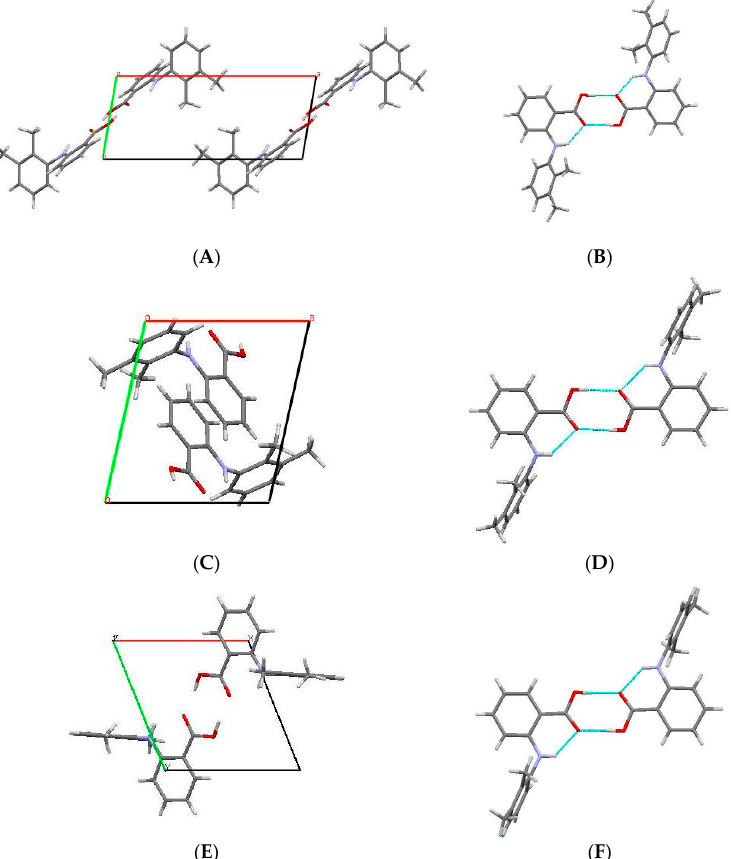
Figure 3. ( A ) Crystal packing diagram of Form I viewed down the c -axis; ( B ) Dimer unit of MA molecule in Form I; ( C ) Crystal packing diagram of high-pressure Form II viewed down the c -axis; ( D ) dimer unit of MA molecule in Form II; ( E ) Crystal packing diagram of Form III viewed down the c -axis; ( F ) Dimer unit of MA molecule in Form III.